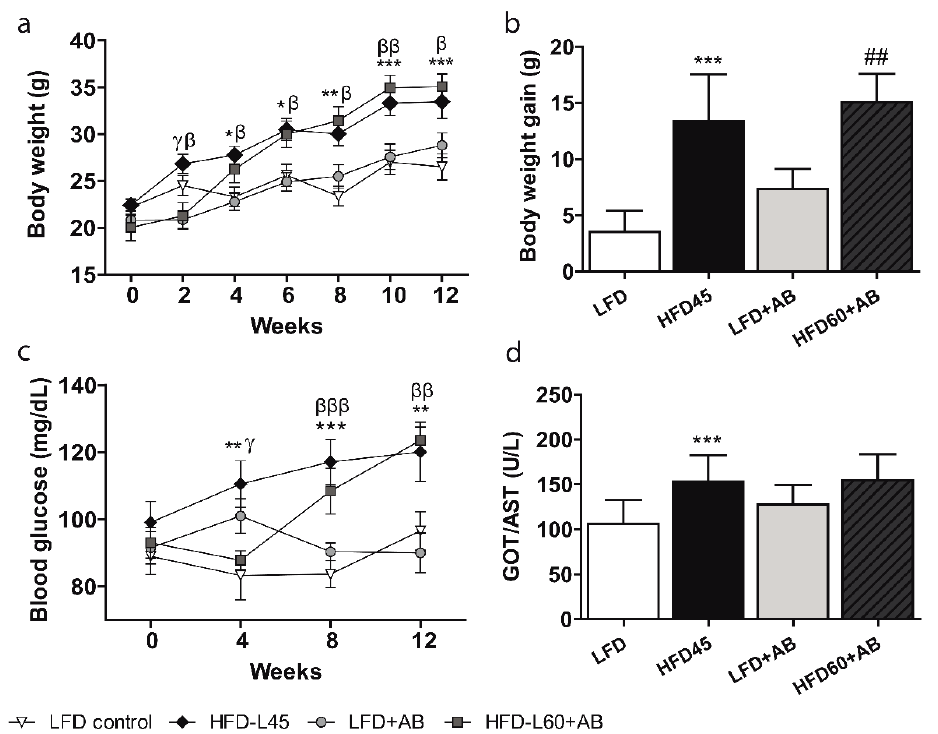
Figure 2. BW and biochemical blood parameters of LDLR-/- mice during 12 weeks of nutritional intervention with AB extract. ( a ) Changes in BW during the 12-week period. ( b ) BW gain at 12 weeks. ( c ) Glycaemia during the 12-week period. ( d ) Final GOT/AST levels. All data are shown as the means ± SD ( n = 5). * p ≤ 0.05/ ** p ≤ 0.01 /*** p ≤ 0.001 HFD45 vs. LFD; β p ≤ 0.05/ ββ p ≤ 0.01/ βββ p ≤ 0.001 HFD45 vs. LFD+AB; γ p ≤ 0.05 HFD45 vs. HFD60+AB; ## p ≤ 0.01 LFD+AB vs. HFD60+AB. The interaction of diet and time, with respect to body weight and glycemia, was analyzed by a two-way